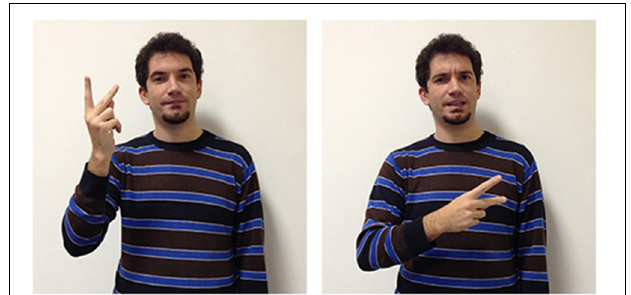
FIGURE 11 | LIS sign POSSIBLE AAA .